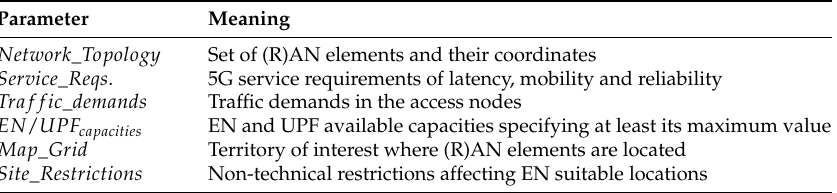
Figure 3. A generic representation of the framework output for the ENs and UPFs placement. Table 1. Framework input